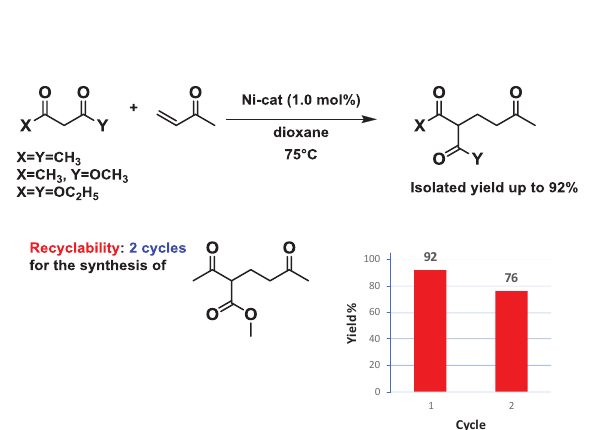
3 Catalytic activity of